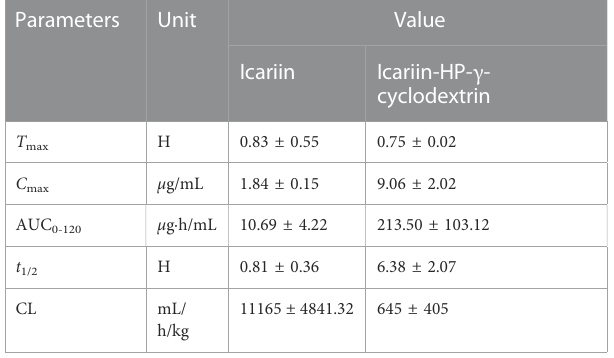
TABLE 2 Pharmacokinetic parameters of icariin and its HP- γ -cyclodextrin complex.